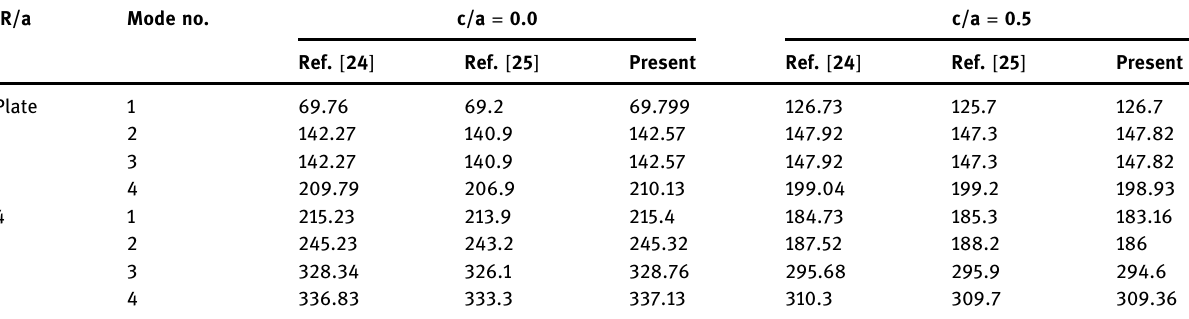
Table 2: Comparison of frequencies in Hz for the CCCC cylindrical curved panel with and without cutout R/a Mode